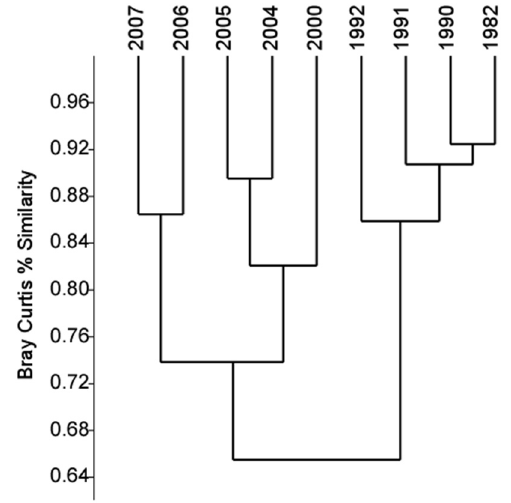
Figure 4. Dendrogram derived from cluster analysis of percent similarity values for the seven-taxa matrix of average summer phytoplankton community counts in the inner bay locations of Green